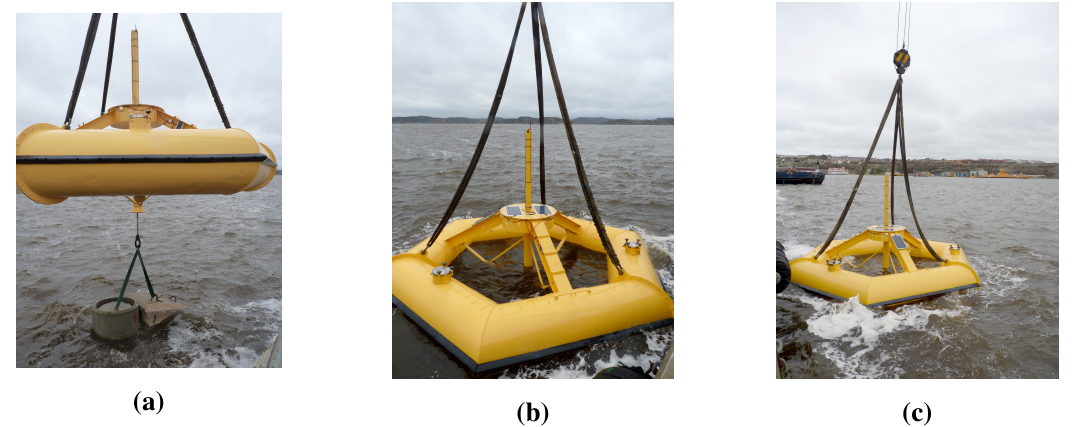
Figure 11. Pictures of the harbor test. ( a ) Concrete weights for a total of 2.5 tons; ( b )